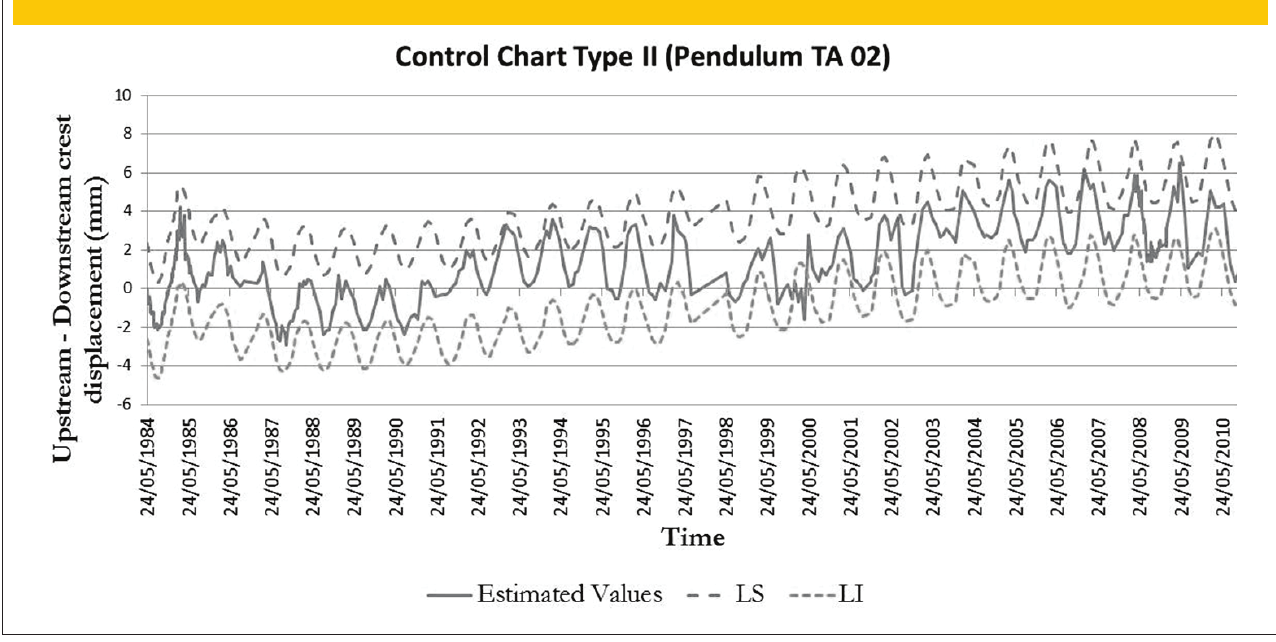
Figure 6 – Control chart for the regression values of the direct pendulum, Control Type II